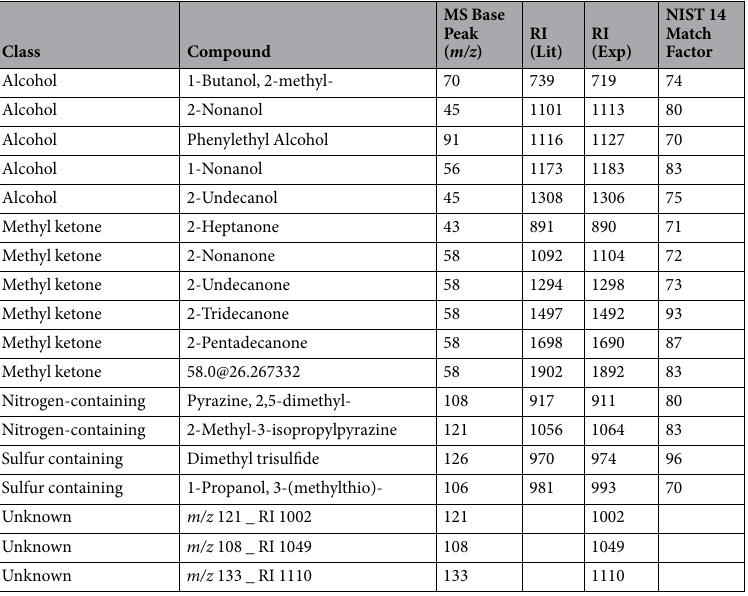
Table 2. Annotations of F. tularensis novicida- specific VOC markers through compound class, putative NIST ID, m/z , and retention index